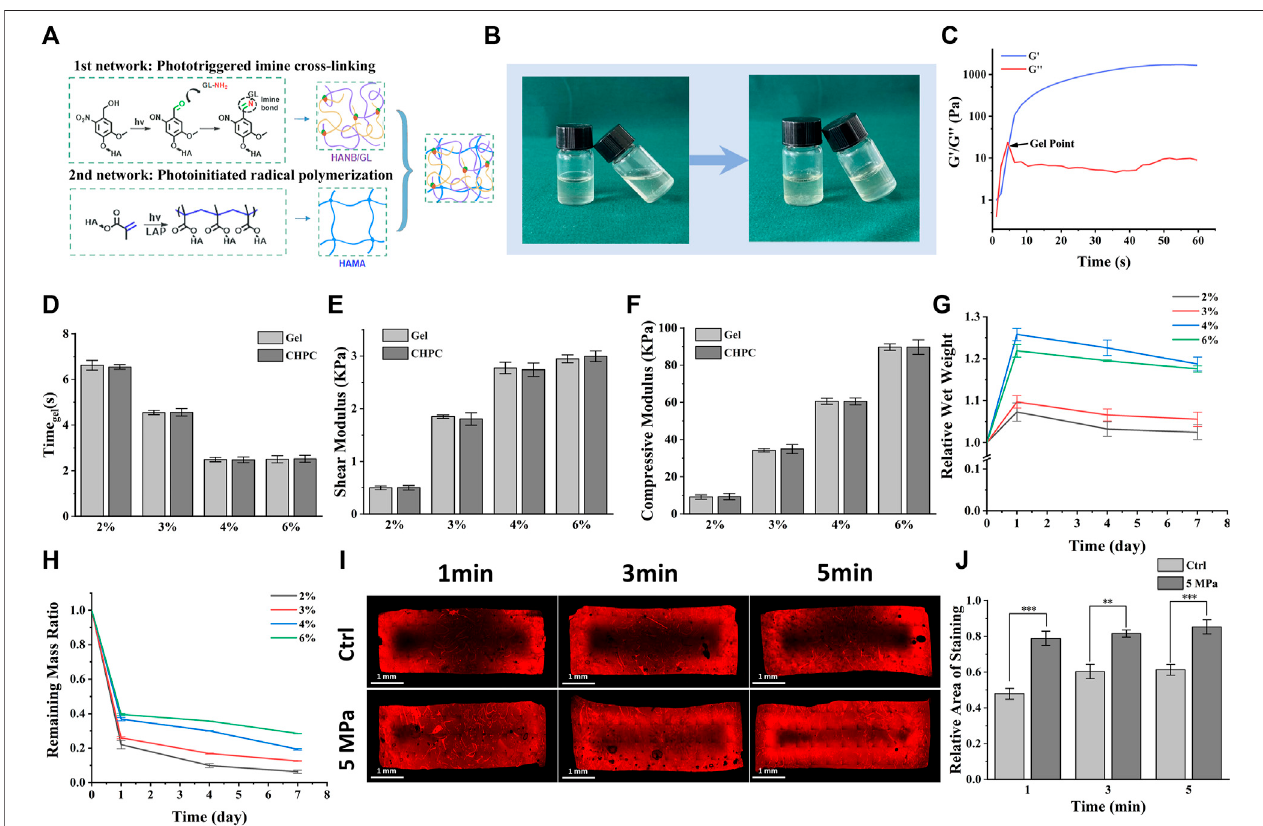
FIGURE1| Propertiesofcell-ladenHPChydrogelsundervariousconcentrations. (A) SchematicofHPChydrogelconstructionmechanismandtheconstructionof double-networks. (B) Images of the HPC hydrogels before and after cross-linking under light irradiation. (C) Rheological measurement displaying storage modulus (G ′ ) , lossmodulus(G ″ ),andgelpoint. (D – F) Gelationtime (D) ,shearmodulus (E) ,andcompressivemodulus (F) ofHPChydrogelswithdifferentconcentrationsloadingornot loading cells. (G) The relative wet weight of HPC hydrogels increased as their concentrations increased. (H) The remaining mass in collagenase and hyaluronidase solution(0.15% w/v) indicates theenzymolysisof HPC hydrogels. (I) Thein fl uenceof HPon rhodamine 6G permeation into HPC hydrogels. Thepermeable region in the HP group was obviously larger than in the control group. (J) Semi-quantitative graphical representation of rhodamine 6G permeation exhibiting relative areas of staining ( p <